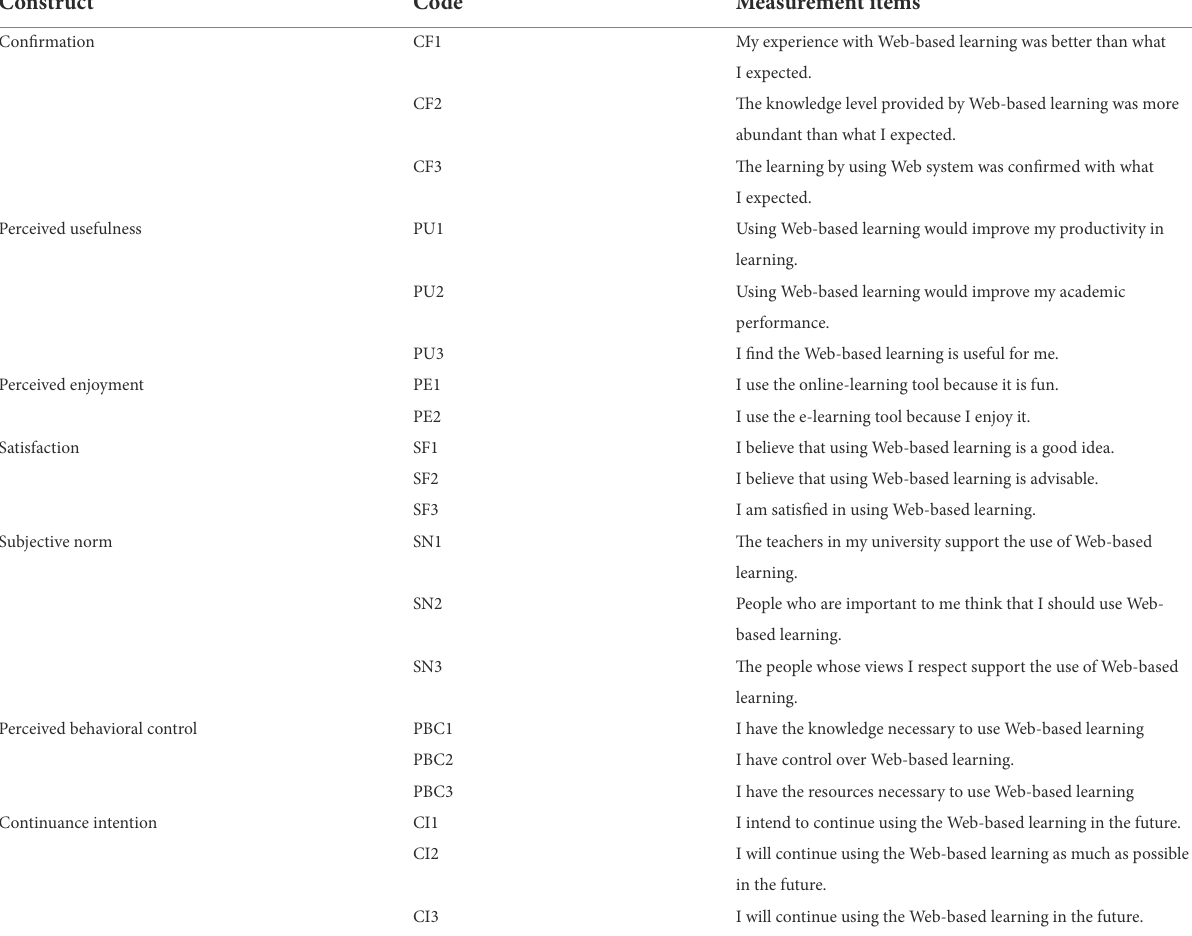
TABLE 1 Measurement